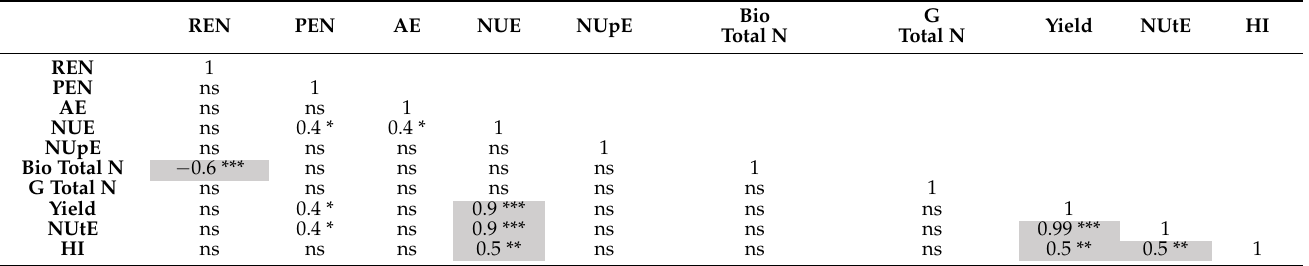
Table 4. Correlation coefficients between variables estimated across different nitrogen application levels.